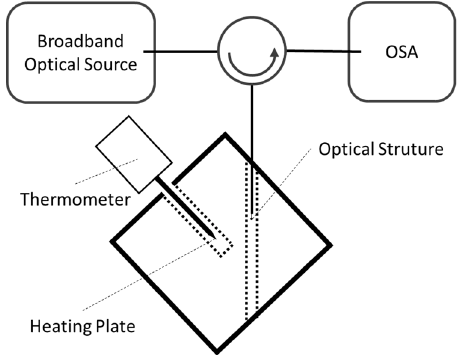
Figure 3. Assembly diagram for temperature variation.